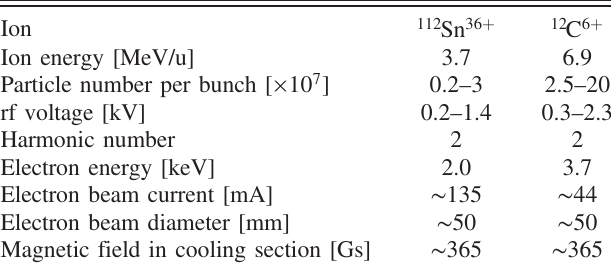
TABLE II. Electron cooling and rf system parameters in the